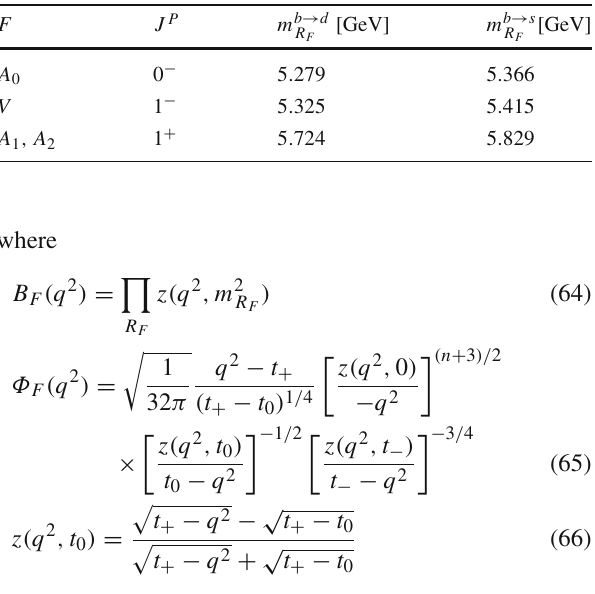
Fig. 3 B → K ∗ at q 2 =